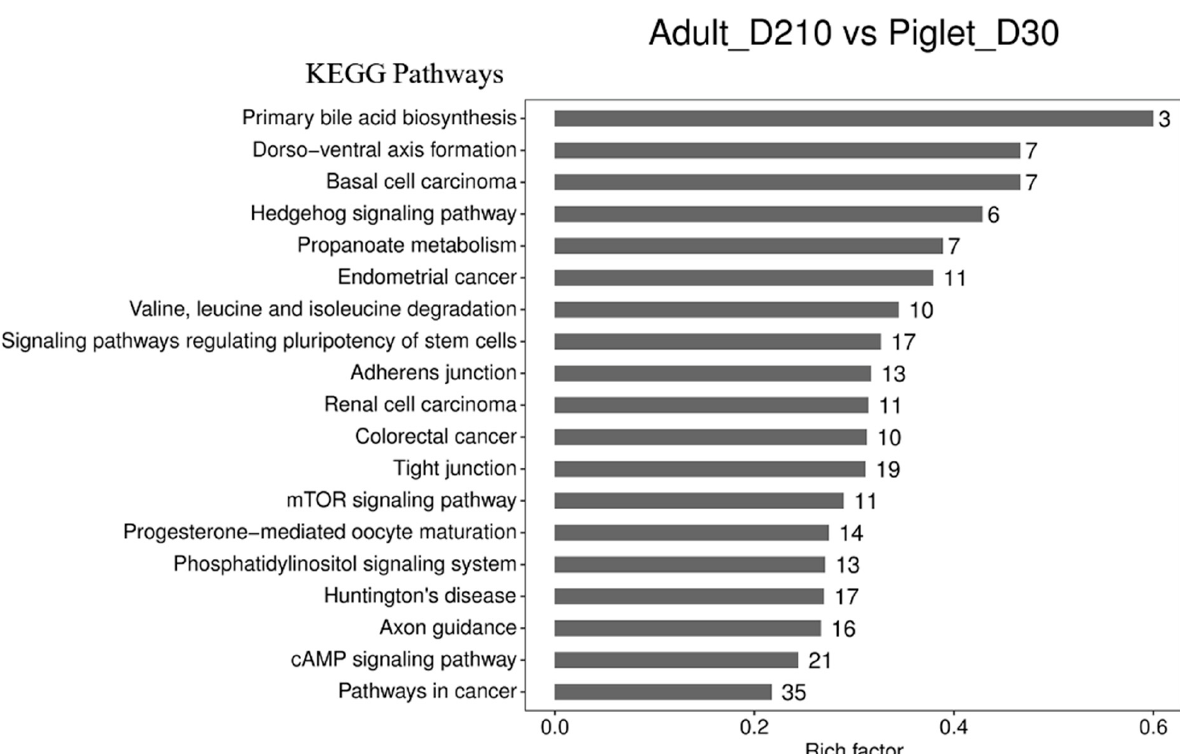
Animals 2021 , 11 , x 12 of 17 Figure 5. Gene ontology (GO) analysis of differentially expressed circRNA source genes. GO analysis of the top enriched terms of the differentially expressed circRNA hosting genes identified in young (Piglet-D30) and sexually mature (Adult- D210) boar testes. The source genes are divided into three ontologies by GO analysis (left: biological process, middle: cells, organ components, right: molecular function). Moreover, analysis of the results showed that 1527 source genes that produce signif- icant differences in circRNA expression ( p Value < 0.05)during testicular development are enriched in 249 signal pathways (Table S6), 19 of which are significantly different ( p Value < 0.05) (Figure 6), such as signal pathways that regulate stem cell pluripotency ( AKT3, AVCVR2A, FGFR1, ACVR1, FZD3, SMAD4, etc.), tight junction ( MYH15, PRKCA, AMOTL1, PPP2CB, CDC42, PTEN , etc.) and adhesion connections ( LEF1, NECTIN3,